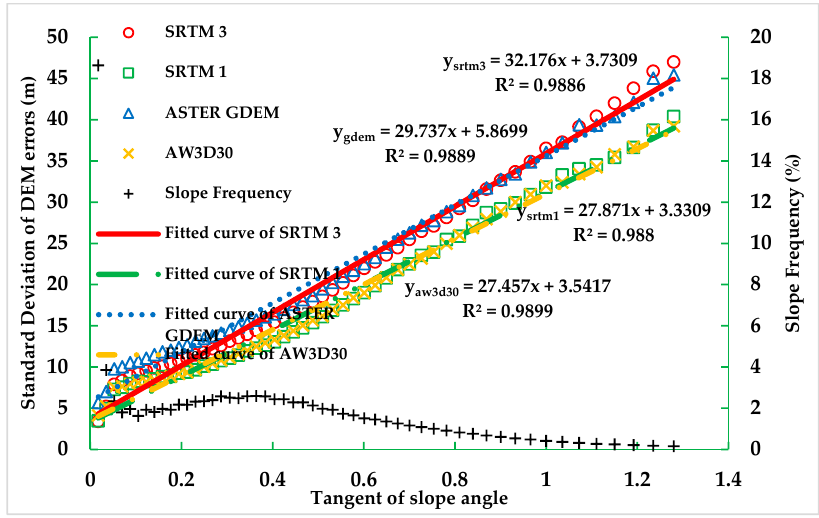
y srtm3 = 32.176x + 3.7309 R² = 0.9886